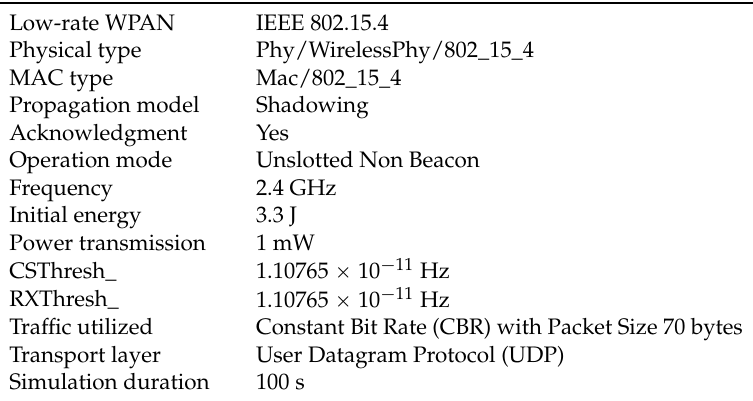
Table 3. Network parameters used to simulate the security